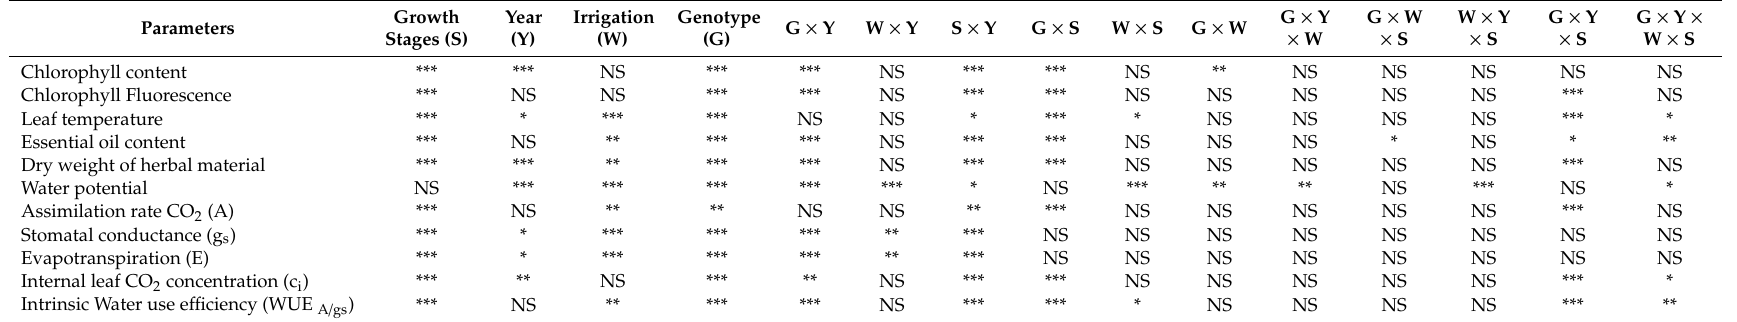
Table 2. Analysis of variance results (significance of the e ff ects) for testing the e ff ects (main and interactions) of Year (Y), Irrigation (W), Cultivar (C), and Growth Stages (S) on the measured plant characteristics.